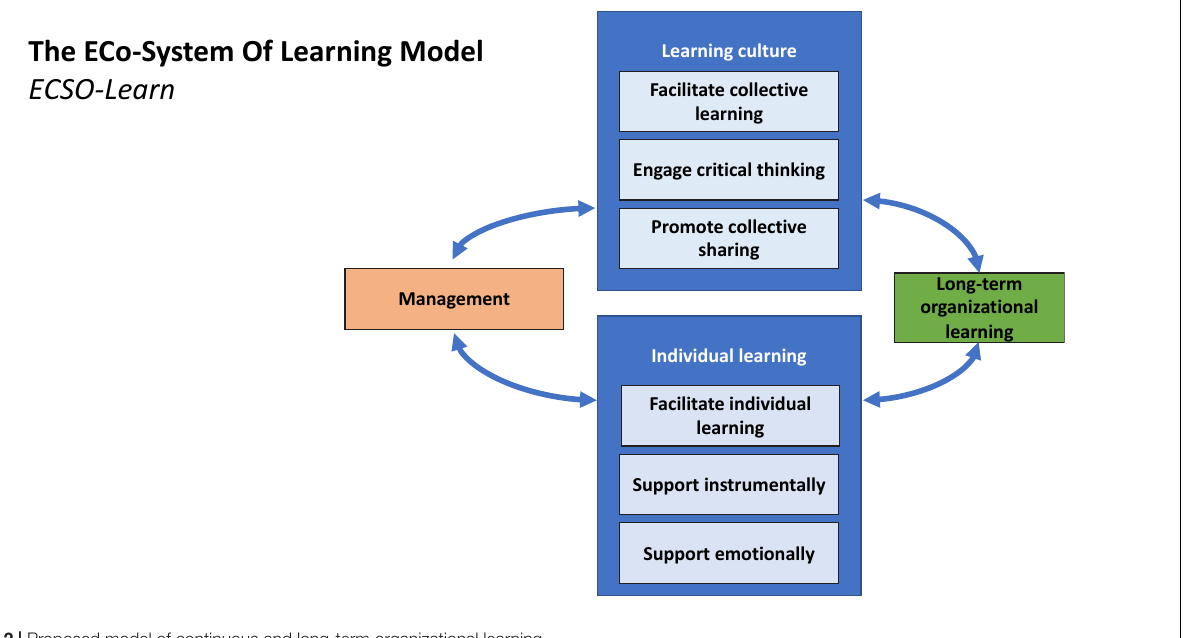
FIGURE 2 | Proposed model of continuous and long-term organizational